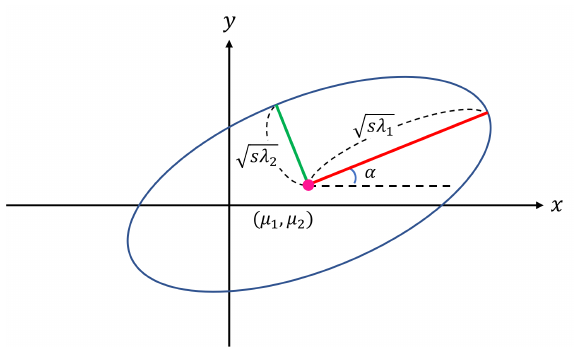
Figure 2. Confidence ellipse derived from the Gaussian